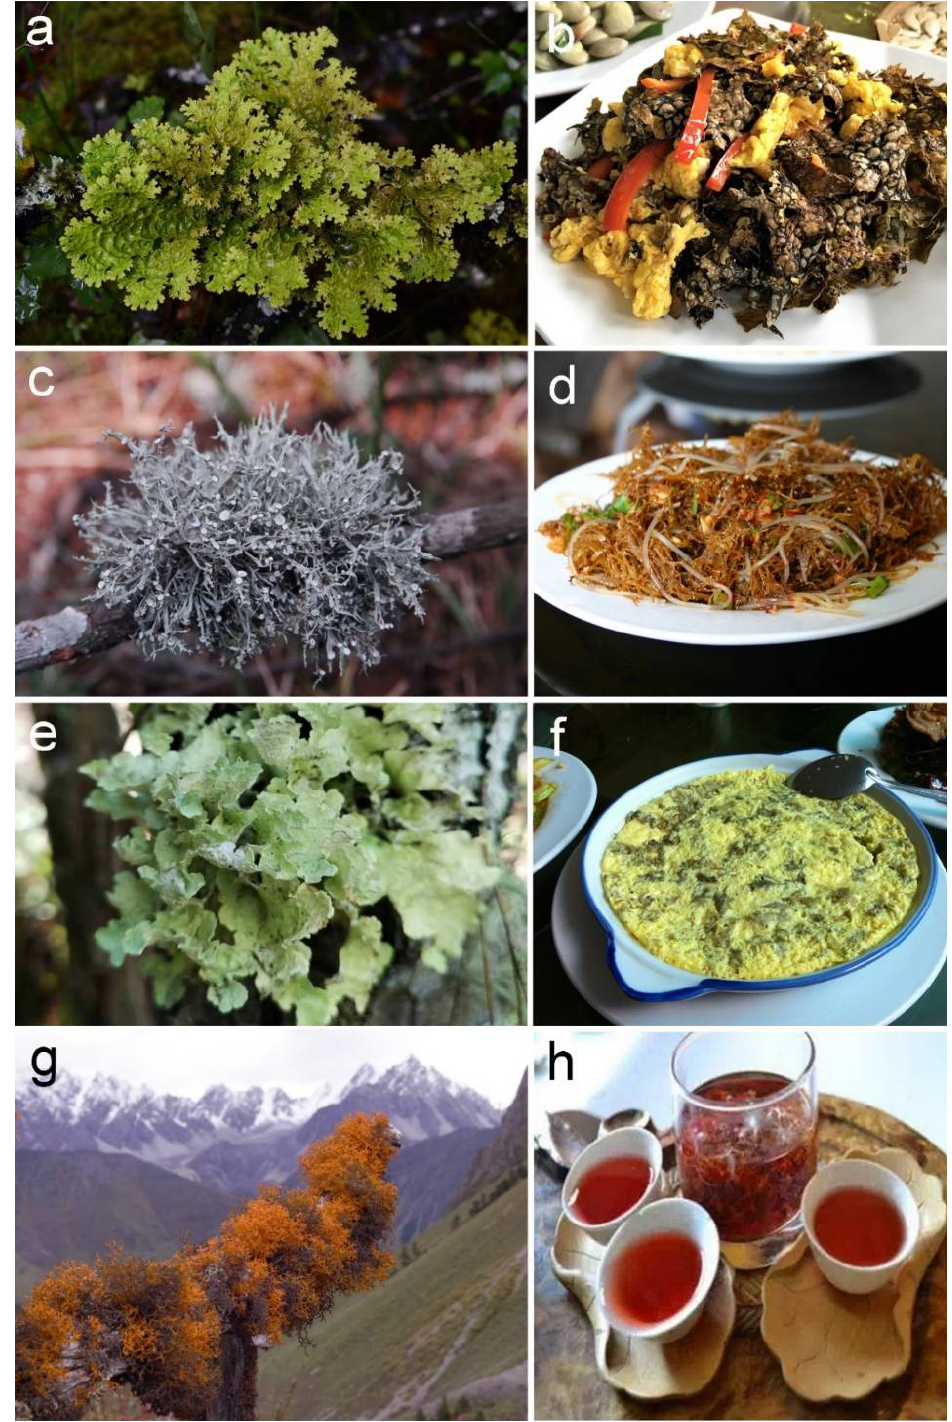
Figure 4. Selected edible lichens in the Himalayas and southwestern China. ( a ) Lobaria ; ( b ) Scrambled eggs with Lobaria ; ( c ) Ramalina fastigiata ; ( d ) “Liang Ban” Ramalina ; ( e ) Nephromopsis pallescens (Schaer.) Y.S. Park; ( f ) Egg custard with Nephromopsis pallescens ; ( g ) Lethariella ; ( h ) Lethariella tea. Photographed by Li-Song Wang.